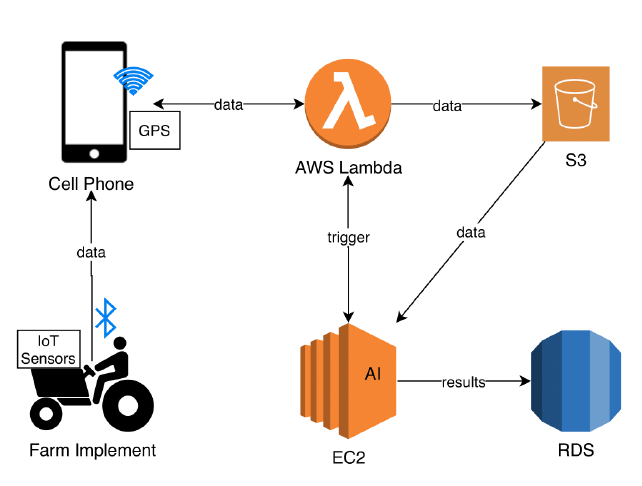
Figure 1. The system architecture diagram showing communication between Internet of Things (IoT) devices and the